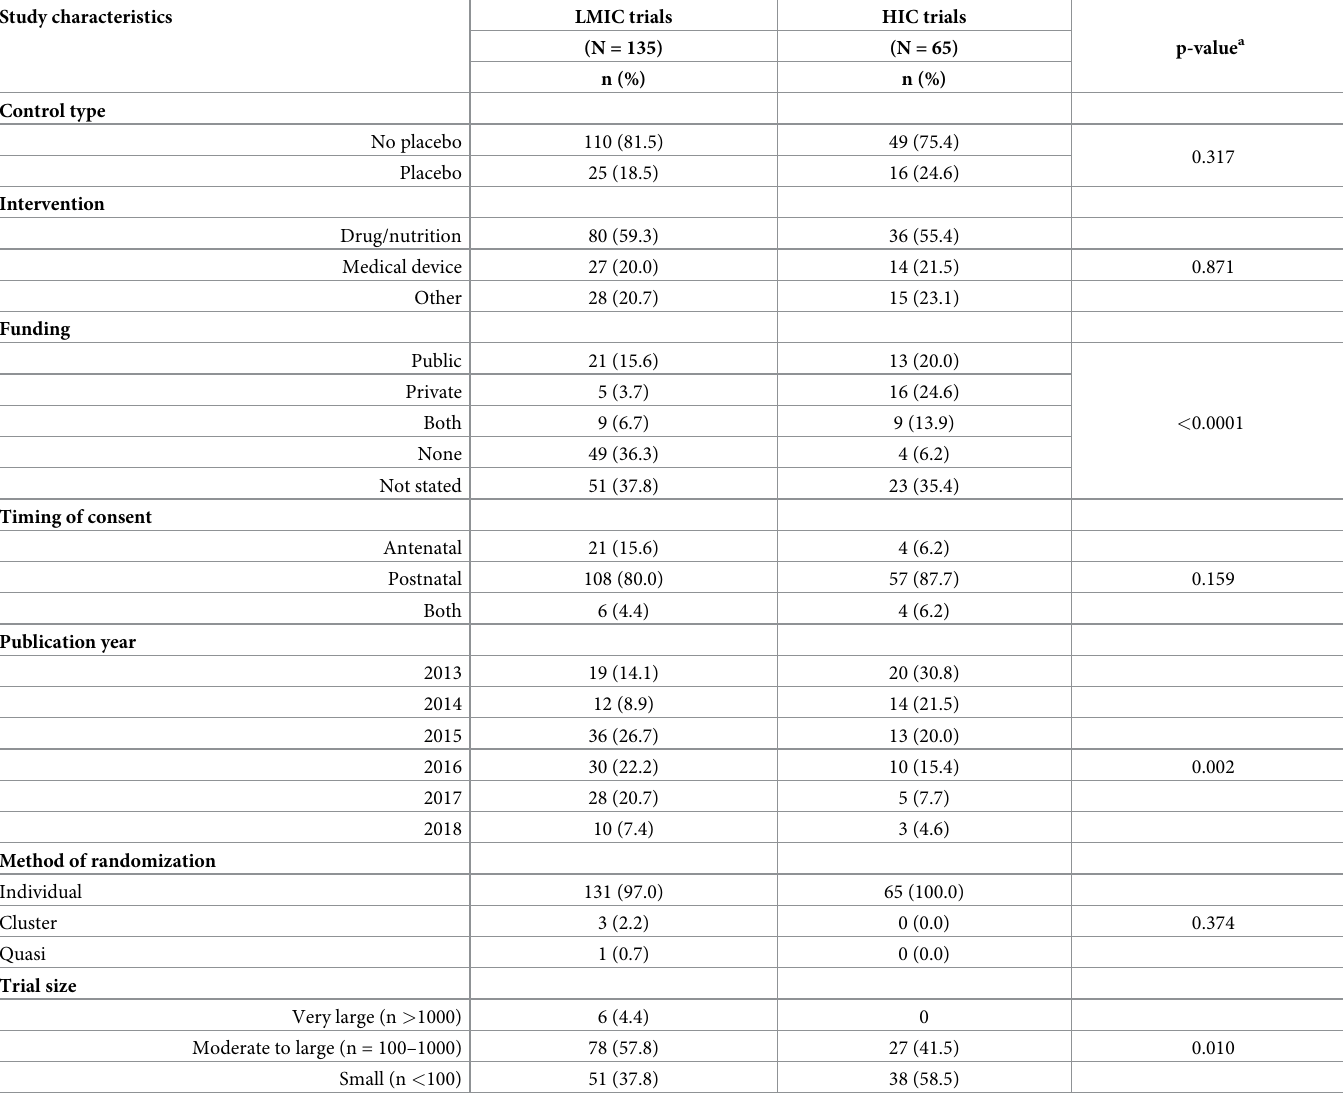
Table 1. Study characteristics of neonatal randomized controlled trials by LMIC versus HIC. Study